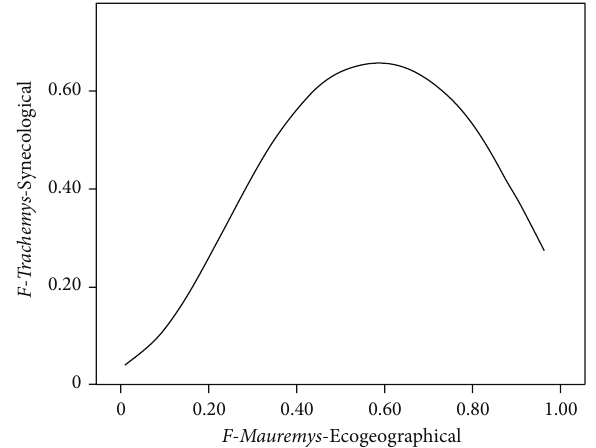
Figure 3: Synecology favourability model ( F - Trachemys -Syneco- logical) for Trachemys scripta as a function of ecogeographical favourability model ( F - Mauremys -Ecogeographical) for Mauremys leprosa .